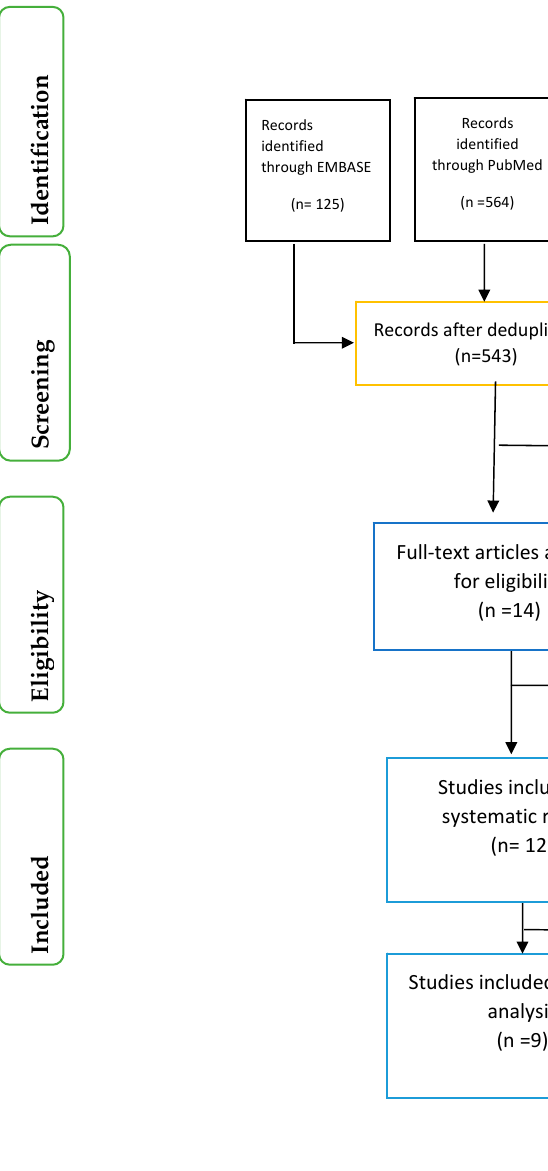
Figure 1. Prisma flow